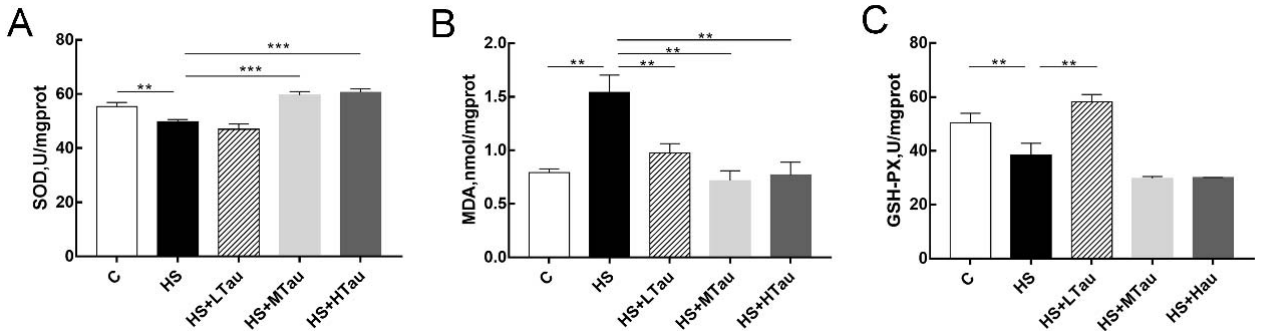
Figure 4. Taurine improved the activities of antioxidant enzymes and the antioxidant capacity of heat-induced MAC-T cells. ( A ) the activity of superoxide dismutase (SOD), ( B ) malondialdehyde (MDA) production, and ( C ) glutathione peroxidase (GSH-PX) activity. ** p < 0.01, and *** p < 0.001.